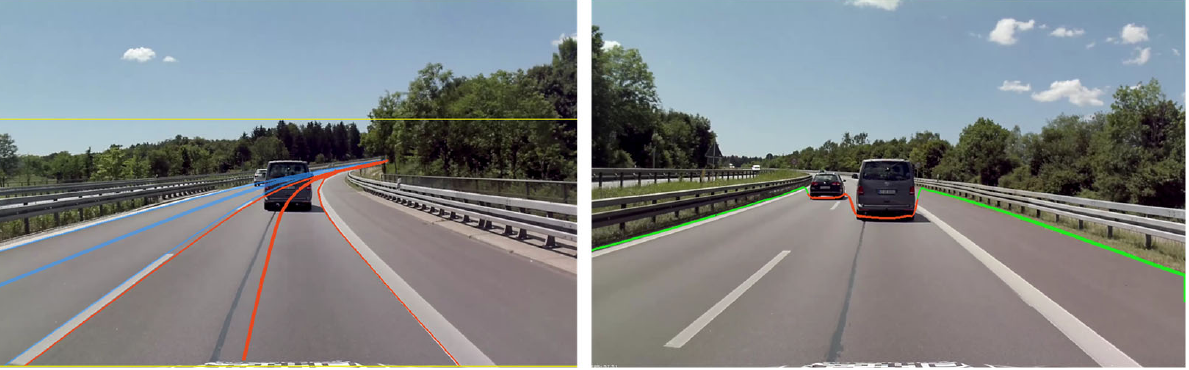
Figure 6. Application of state ‐ of ‐ the ‐ art neural networks for path detection ( left ) and free space detection ( right ) on a highway.